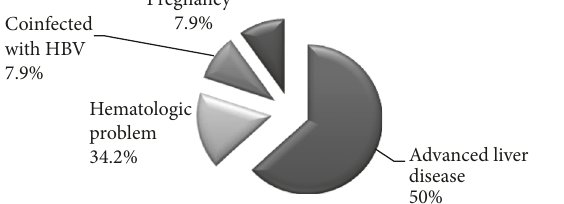
Figure 3: Adverse events for Sofosbuvir/Daclatasvir